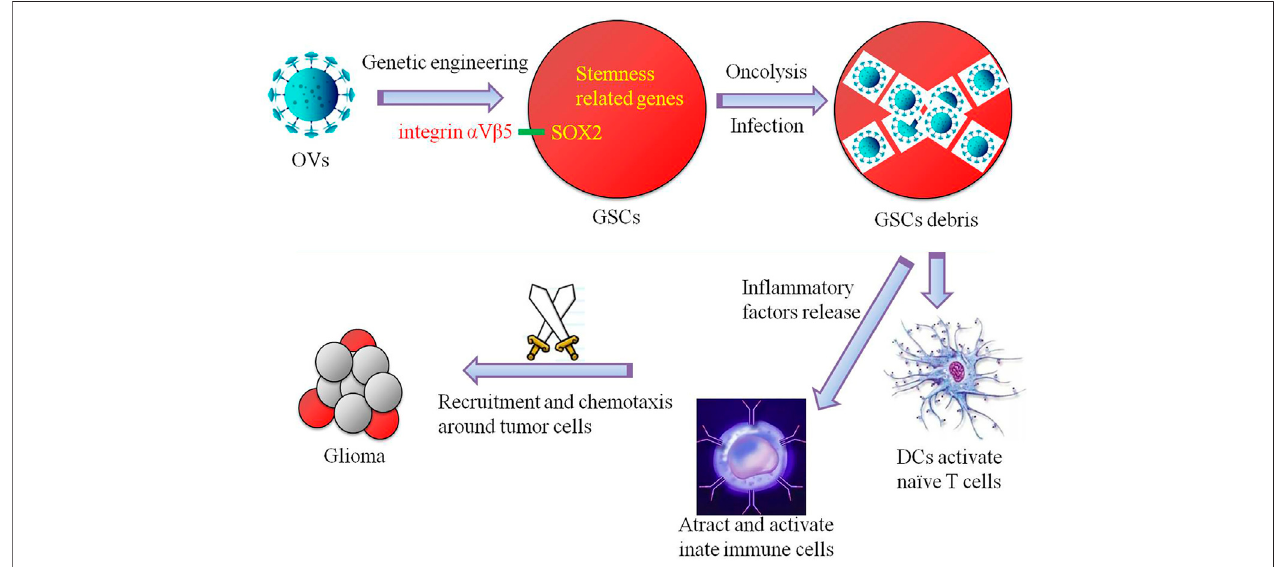
FIGURE1| Schematicdiagramofasimplesimulationofthemechanismbywhichoncolyticviruses(OVs)targetinggliomastemcells(GSCs)exertglioma-inhibiting action. GSCs infected by genetically engineered oncolytic viruses that target dry-associated genes (e.g., SOX2-integrin α V β 5 axis) can be cleaved directly to destroy GSCs, and additional immune cells are recruited and chemotaxis around gliomas through the release of in fl ammatory factors to kill and inhibit gliomas.